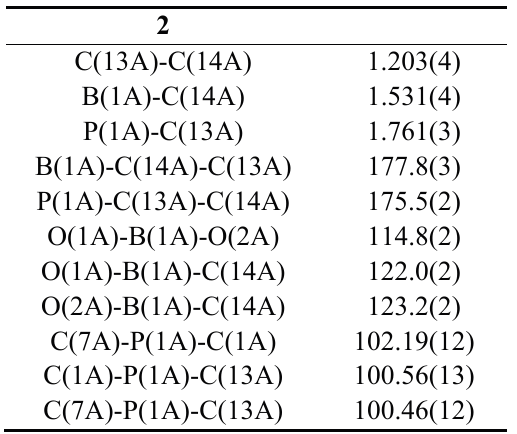
Table 1. Selected bond lengths ( Ǻ ) and angles (°) for 2 .